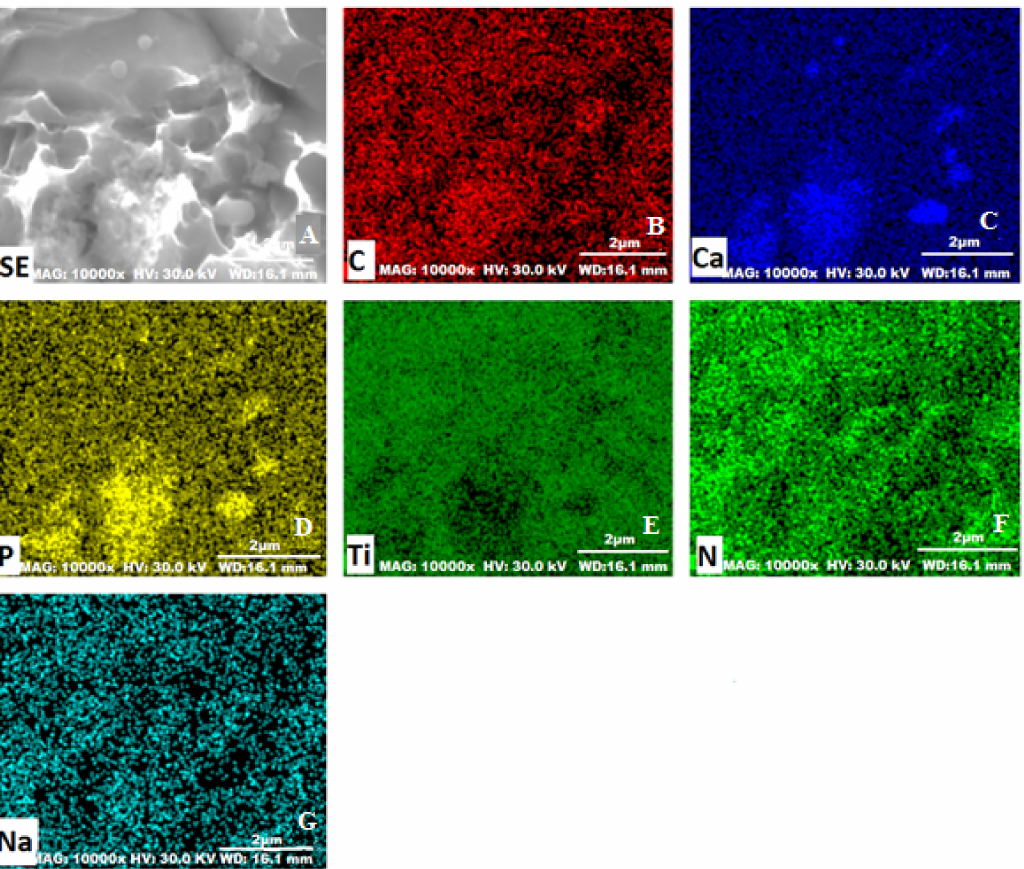
Figure 4. SEM-EDX ionic distribution of the HA-AL films on titanium: ( A ) Secondary electron (SE) image; SEM images and X-ray mapping of elemental ( B ) Carbon (C); ( C ) Calcium (Ca); ( D ) Phosphor (P); ( E ) Titanium (Ti); ( F ) Nitrogen (N); ( G ) Sodium